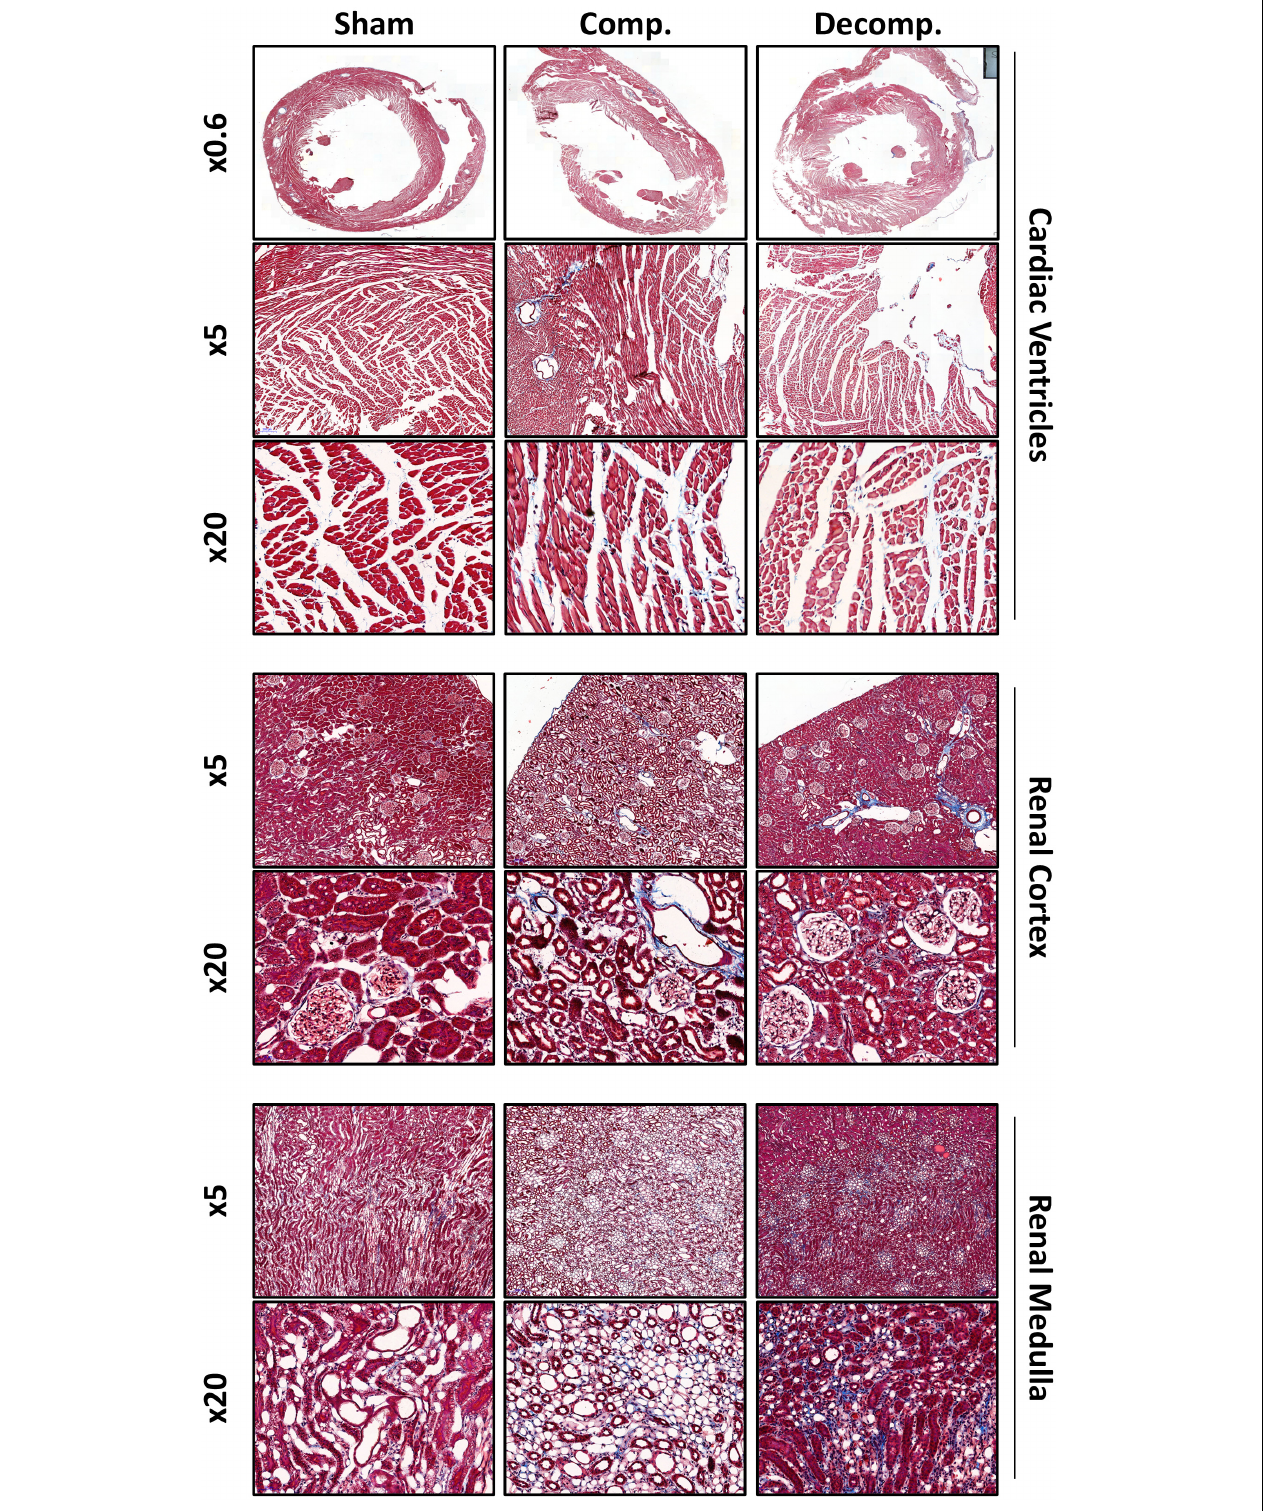
FIGURE 2 | Tissue fibrosis in ACF rats. Representative images of Masson’s trichrome staining of the cardiac ventricular and renal tissues, as well as renal cortical and medullar layers, illustrating the impact of ACF placement on the development of tissue remodeling, compared with sham operated rats. Images are presented at x0.6, x5, and x20